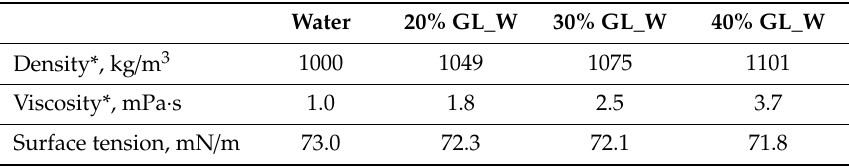
Table 1. Physical properties of the aqueous phases used as